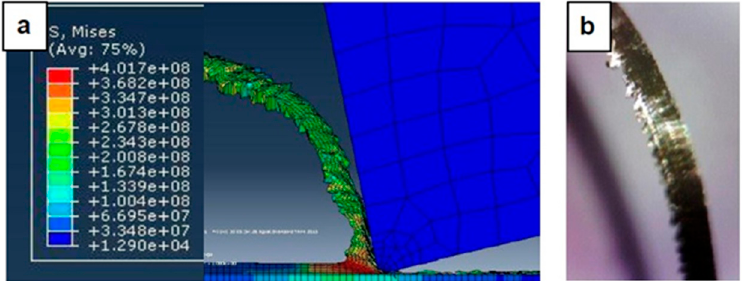
Figure 13. Machining Stainless Steel 316L at feed rate 0.07 mm / rev: ( a ) Chip formation and ( b ) produced chip.